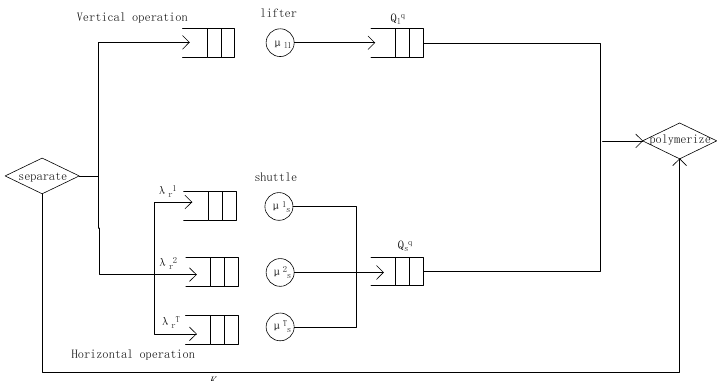
Figure 4. Closed-loop queuing network using the parallel strategy .